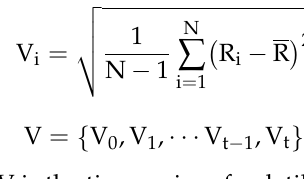
Table 2. Hurst exponent of volatility sequence.